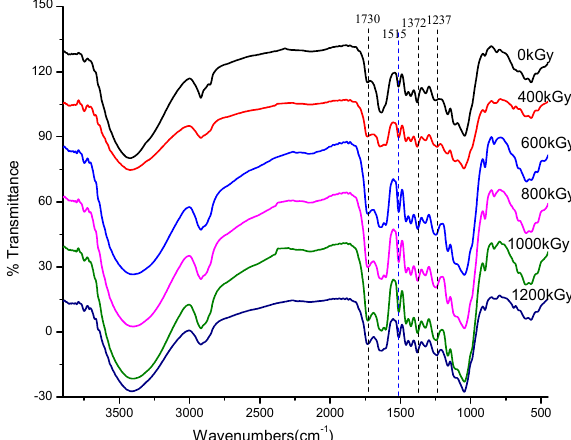
Figure 4. FTIR spectra of Miscanthus irradiated with different absorbed doses.